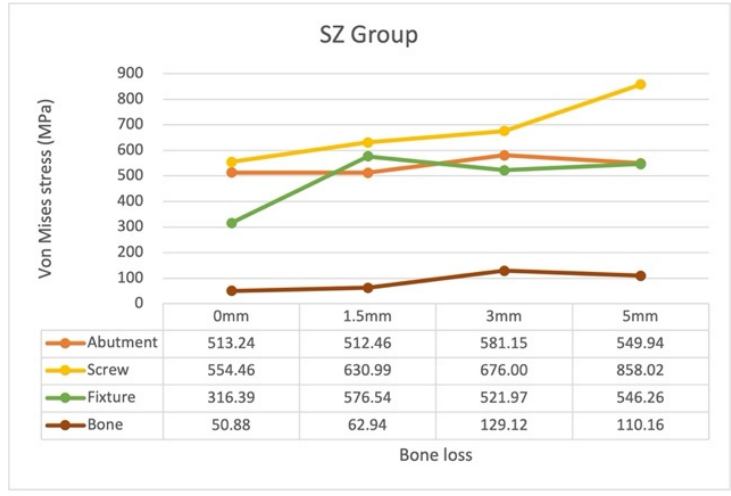
Figure 12. Maximum von Mises stress on the abutment, screw, fixture, and bone in the SZ groups with different bone loss levels.